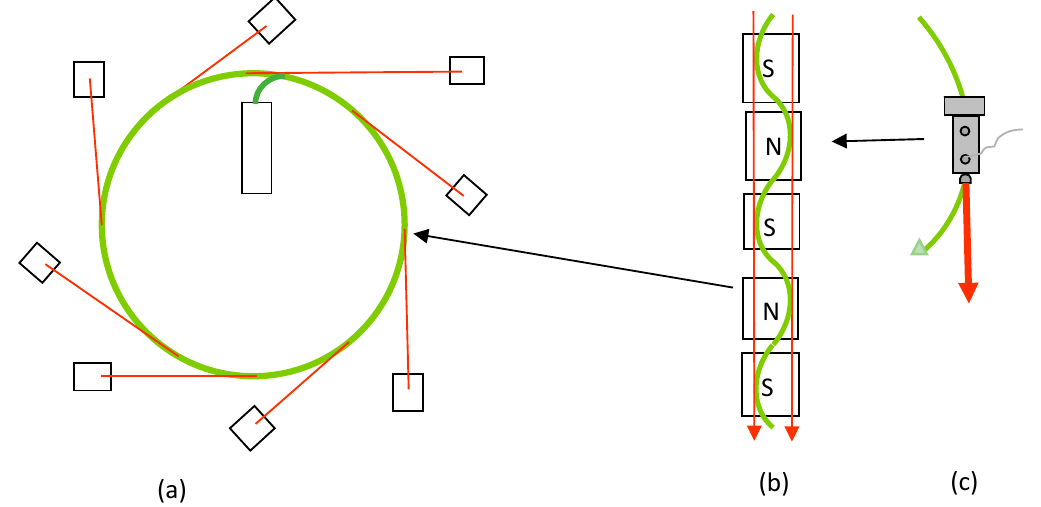
Figure 1. ( a ) Diagram of a synchrotron storage ring in which an electron beam (green) is traveling clockwise. ( b ) Every time the electron beam passes through a vertical magnetic field above the north end of a “C-shaped” magnet (N) and below the south end of the “C-shaped” magnet (S), the magnetic field causes the electron beam to be steered to the right. Every time the electron beam passes through the inverted magnetic field, it is steered to the left. Much more intense beams (shown as red arrows) can be produced if the electron beam passes through a series of alternating magnetic fields in a straight section of the ring, so that the beams produced at all the crests and troughs are added together. These are called wigglers or undulators. ( c ) Every time the beam is deflected, some of its energy is converted to an electromagnetic beam shining in a forward direction, like the headlight on a locomotive (c). Pipes leading o ff tangentially from the storage ring at the bending magnets, wigglers and undulators carry the X-ray beams to workstation hutches (rectangles) for experiments. Where there is no magnetic field, the electrons travel in a straight line and produce no electromagnetic